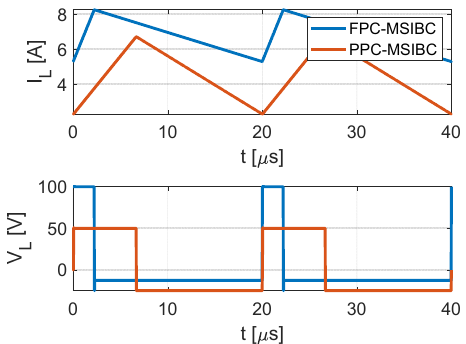
Figure 6. Inductor’s current and voltage steady-state waveforms for the double-inductor topology.